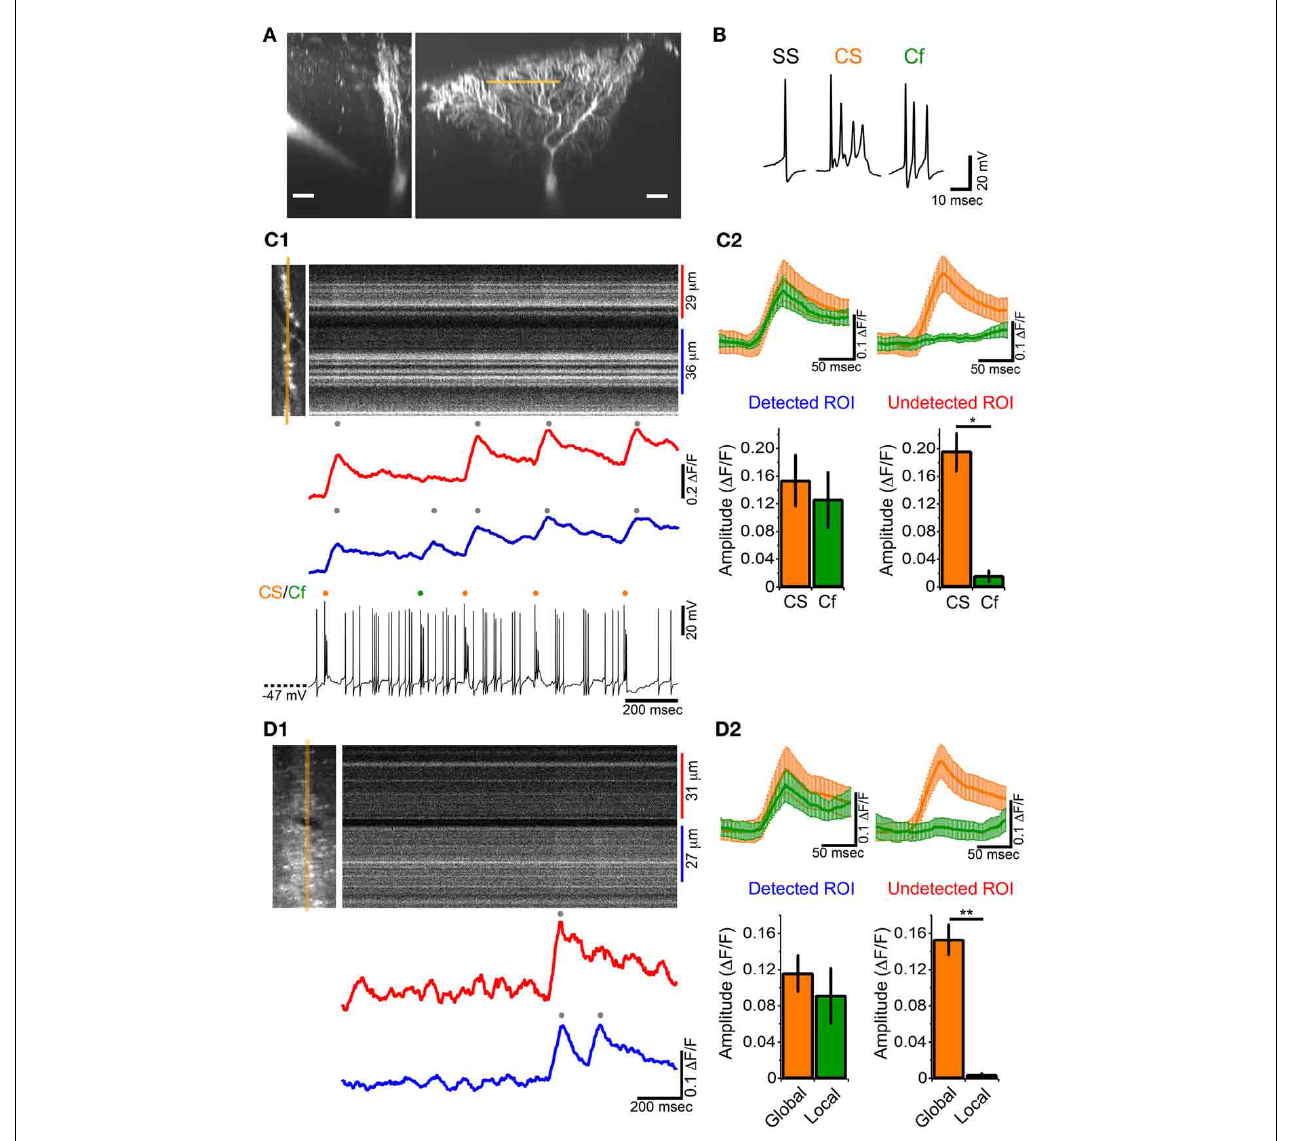
FIGURE 6 | Local calcium transient induced by Cf in GluD2 KO mice. (A) Fluorescence images showing a whole-cell patch-clamped PC of a GluD2 KO mouse in transverse (left) and sagittal (right) views that were taken more than 30min after filling of OGB-1 and Alexa 594 through the patch pipette. Line-scan calcium imaging was performed at distal dendrite ( ∼ 100 μ m from the soma) indicated by orange line. Scale bar, 20 μ m. (B) Sample traces of simple spike (SS), complex spike (CS), and clustered firing (Cf) under current-clamp recording from a GluD2 KO mouse. (C1) Simultaneous whole-cell recording and line-scan calcium imaging was obtained from the PC shown in (A) . Left image indicates the location of line-scan (orange line). ROIs were determined so that local calcium transients could be maximally recorded. The blue trace was obtained from the lower ROI in which local calcium transient was recorded, and the red trace was obtained from the upper ROI in which no local calcium transients were detected for Cf. The onset of local calcium transient coincided with the time when Cf occurred. (C2 ) (upper panels) Average traces of calcium transients induced by CS (orange trace) and by Cf (green trace) in the ROI from which Cf-evoked local calcium transients were detected (Detected ROI) and in the other ROI of the same PC in which Cf-evoked local calcium transients were absent (Undetected ROI). CS- or Cf-evoked calcium transients are shown as mean ± s.e.m from 4 GluD2 KO mice. Note that the